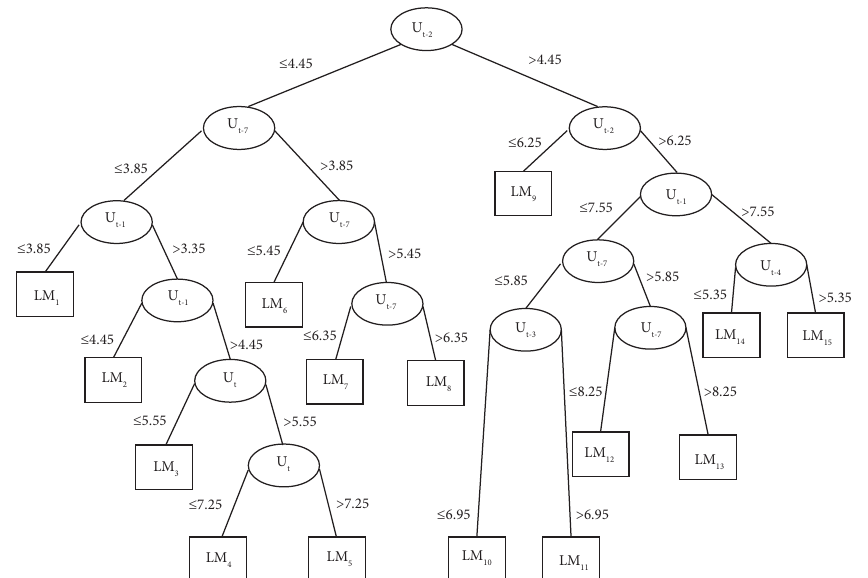
Figure 6: M5MT structure to evaluate wave height.